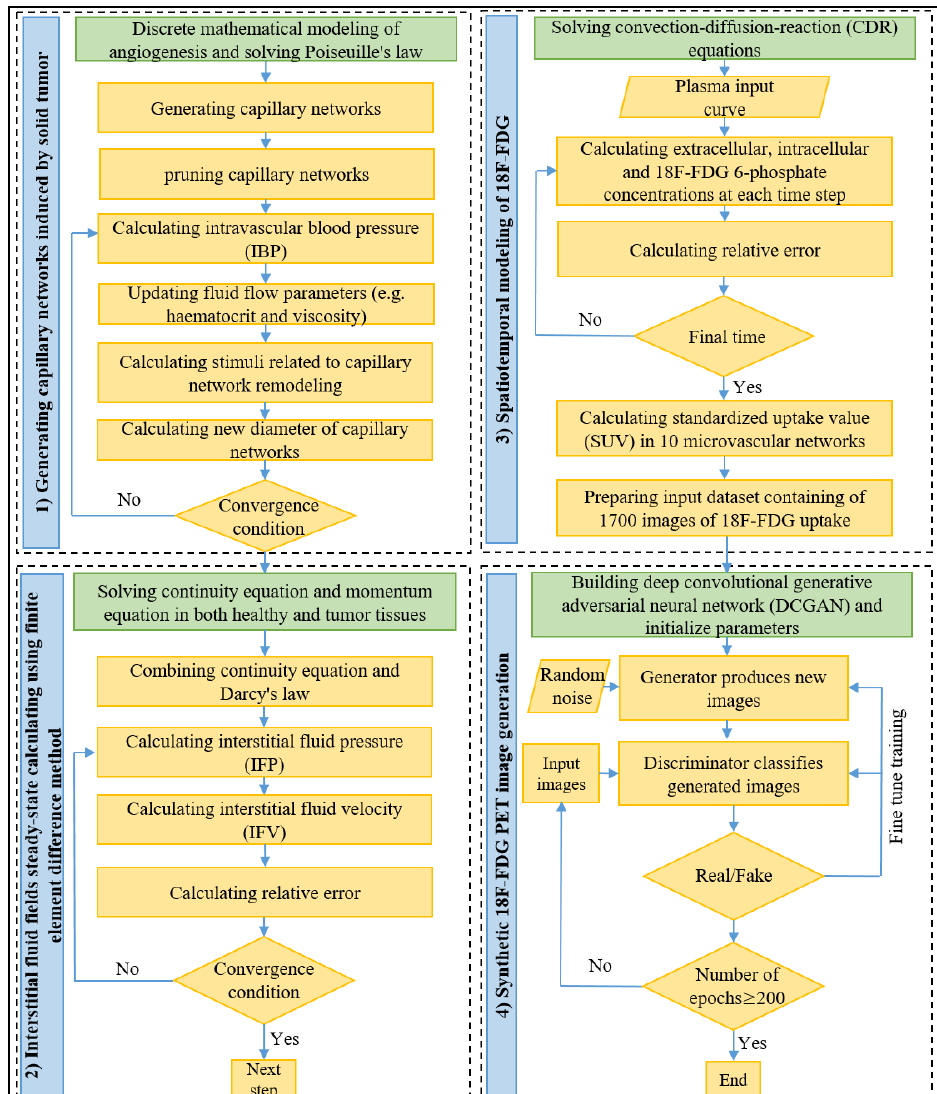
Figure 4. Block diagram showing step-by-step approach used to generate synthetic 18F-FDG PET images. Further details are presented in the solution strategy section.